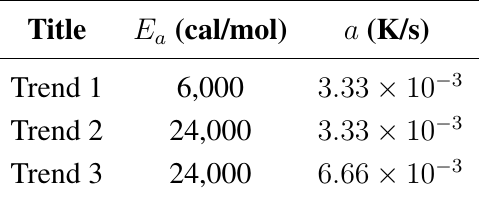
Table 1. The values of the parameters of the exponential trend Equation (13) substantiated in [22].